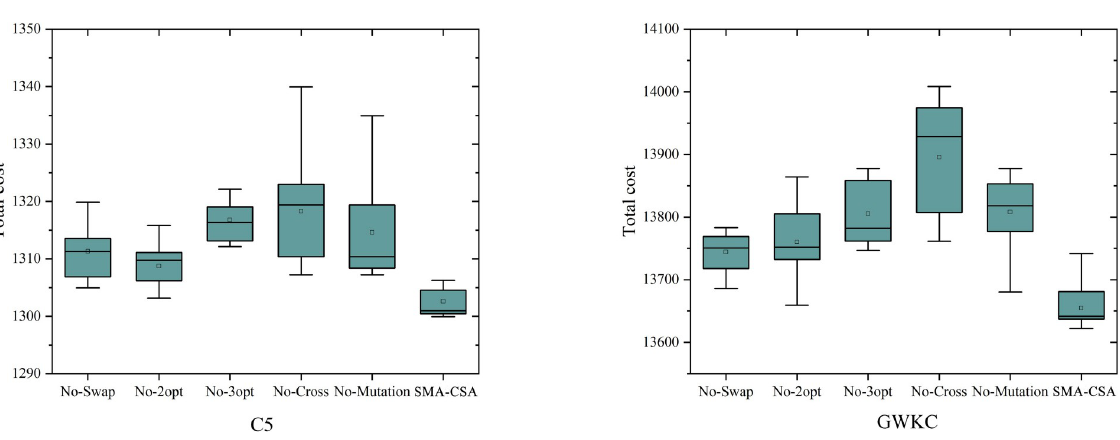
Fig 10. Results when one of the local search or mutation strategies is unused on C5 and GWKC4.